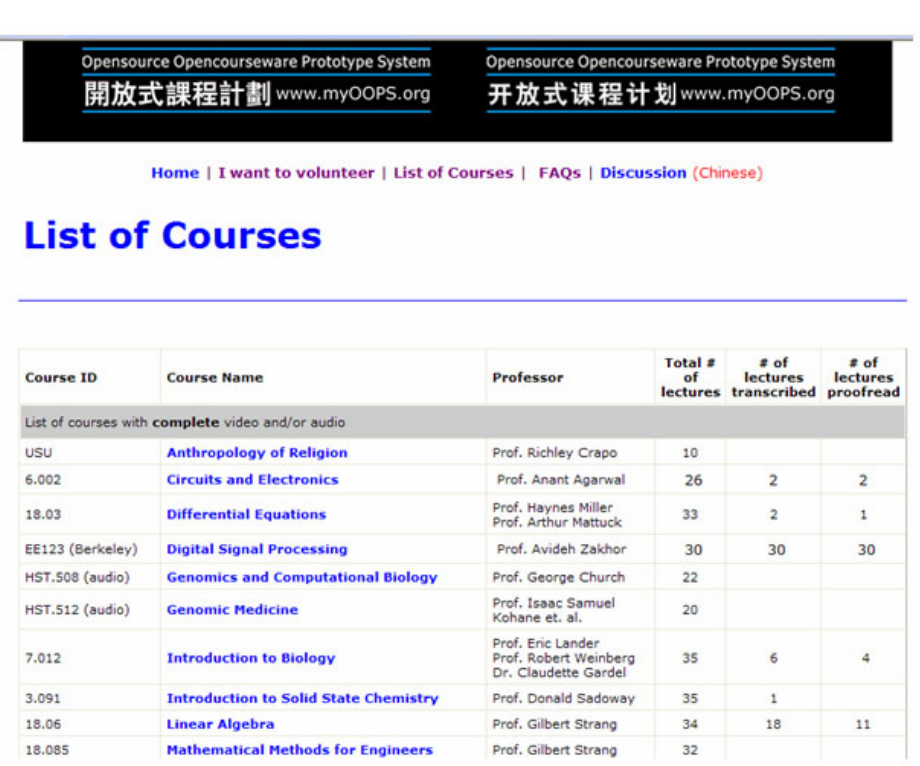
Figure 4. List of MIT courses adopted by OOPS volunteers and progress